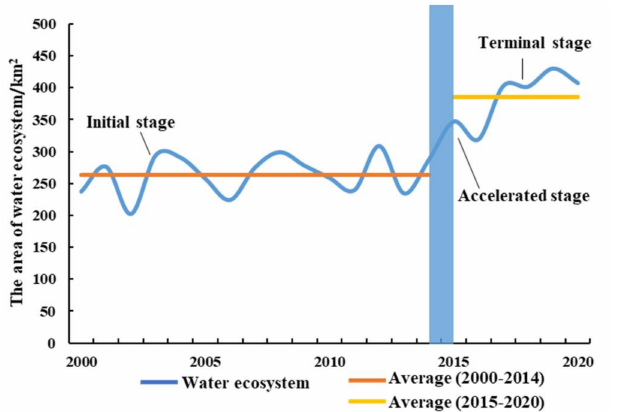
Figure 10. Spatial distribution of annual change for water ecosystem in Xichuan County in ( a )–( e ) 2000, 2005, 2010, 2015 and 2020, respectively.